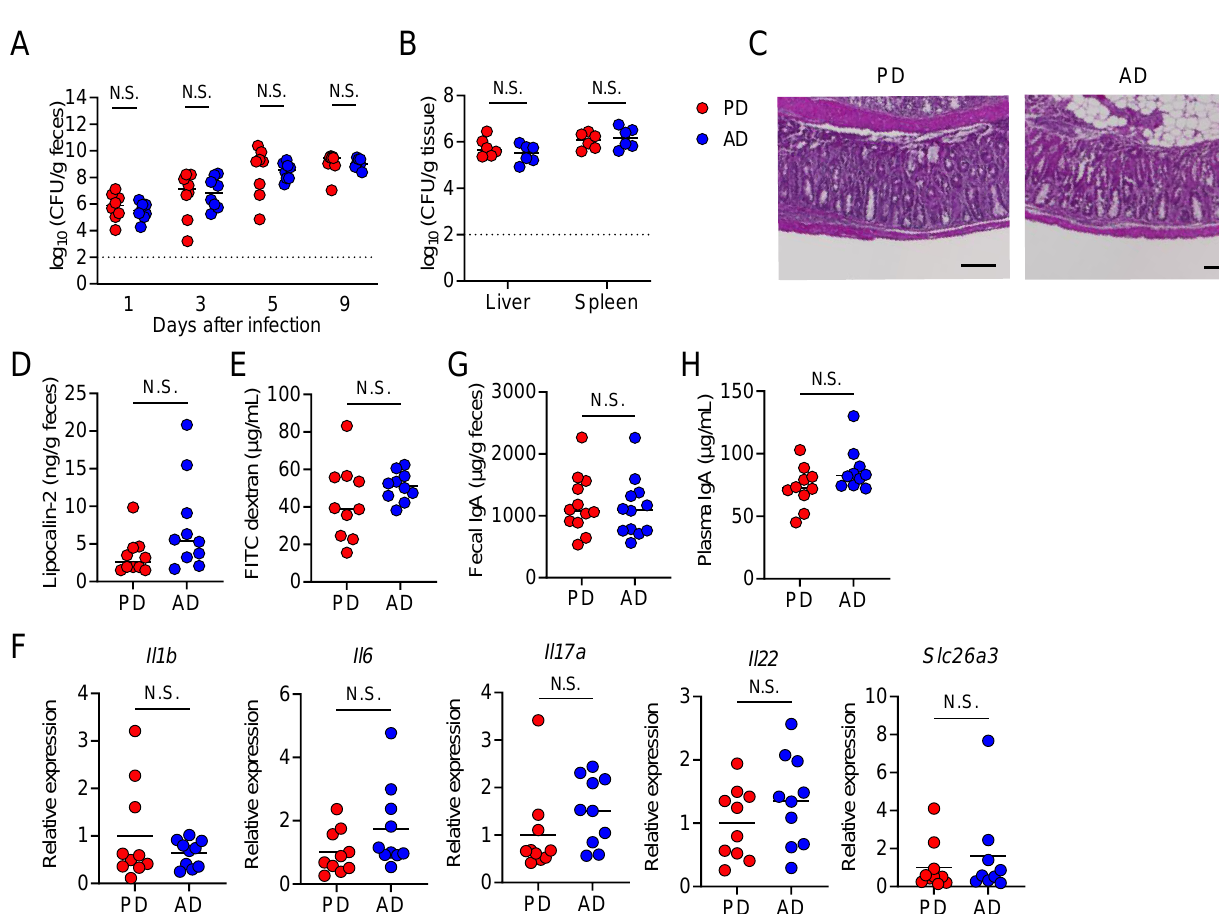
Figure 2. An amino acid-based diet neither promotes pathogen clearance nor suppresses intestinal damage. ( A – F ) Mice fed each diet (PD; regular purified diet, AD; amino acid-based purified diet) were orally infected with C. rodentium ( n = 9–10 in each group). ( A , B ) Fecal pathogen load on 1, 3, 5, and 9 days post-infection ( A ) and in the tissues 10 days post-infection ( B ). ( C ) H&E staining of colon slides from representative infected mice fed PD or AD 10 days post-infection. scale bar, 200 µ m ( D ) Fecal lipocalin-2 concentration 9 days post-infection. ( E ) Plasma concentration of fluorescein isothiocyanate (FITC)-dextran 7 days post-infection. ( F ) Gene expression of Il1b , Il6 , Il17a , Il22 , and Slc26a3 in the colon 9 days post-infection by real-time RT-PCR. mRNA expression of each gene was normalized to that of Rpl19 ( G – H ) Mice fed PD or AD for 2 weeks ( n = 10 in each group). IgA levels in ( G ) feces or ( H ) plasma. Each dot represents an individual mouse, and the horizontal bars indicate mean values. Statistical significance was assessed by two-way ANOVA with ( A , B ) Š í d á k’s multiple comparisons test, ( D , F ( Il1b , Il6 , Il17a , Slc26a3 ), H ) Mann–Whitney test, ( E , F ( Il22 )) unpaired Welch’s t -test, or ( G ) unpaired Student’s t -test. N.S., not significant.